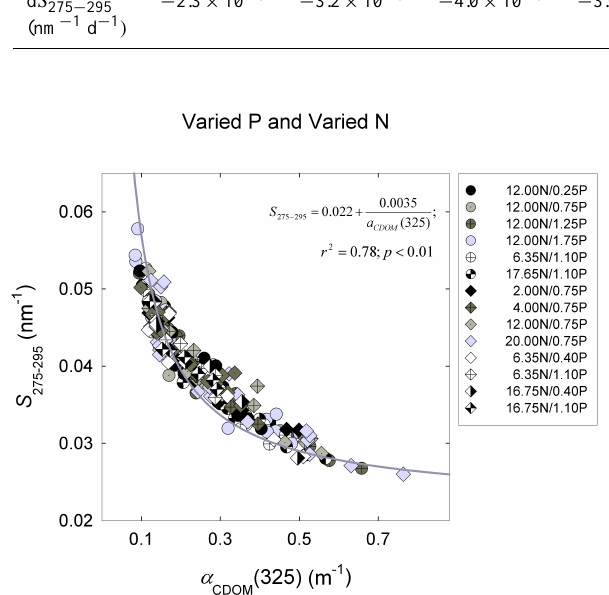
Figure 3. Spectral slope S 275 − 295 against CDOM ( a CDOM (325)) obtained during both, Varied P and Varied N experiments (symbols). The dark-gray line is the best fit to the data.